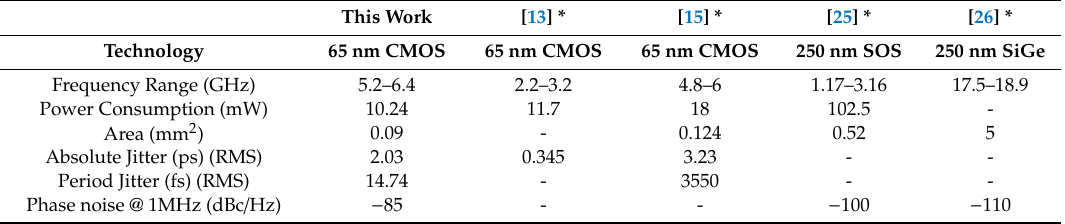
Table 2. Comparison with the state-of-the-art Rad-Hard PLLs. SOS: Silicon On Sapphire. This